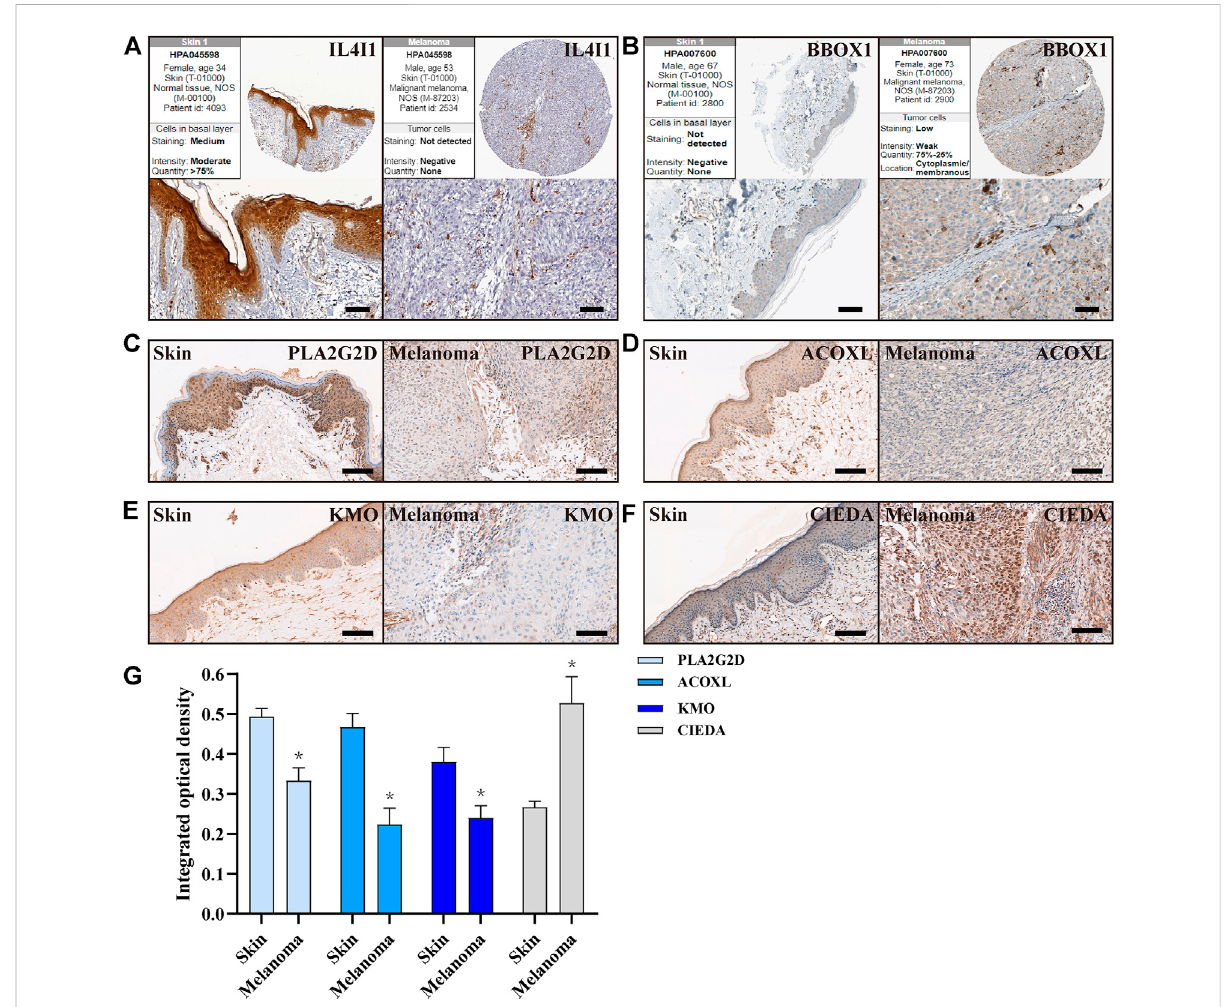
FIGURE 8 Expression of FA metabolism-related genes innormalskin and CM tissues. (A,B) IHCof the IL4I1 and BBOX1 inCM and normalskin tissues from HPA. (C – F) IHC of the PLA2G2D , ACOXL , KMO, and CIDEA in normal skin and CM tissues (n = 3), Scale bar = 100 µm. (G) Quantitative studies of PLA2G2D , ACOXL , KMO, and CIDEA were analyzed by counting the integrated optical density,